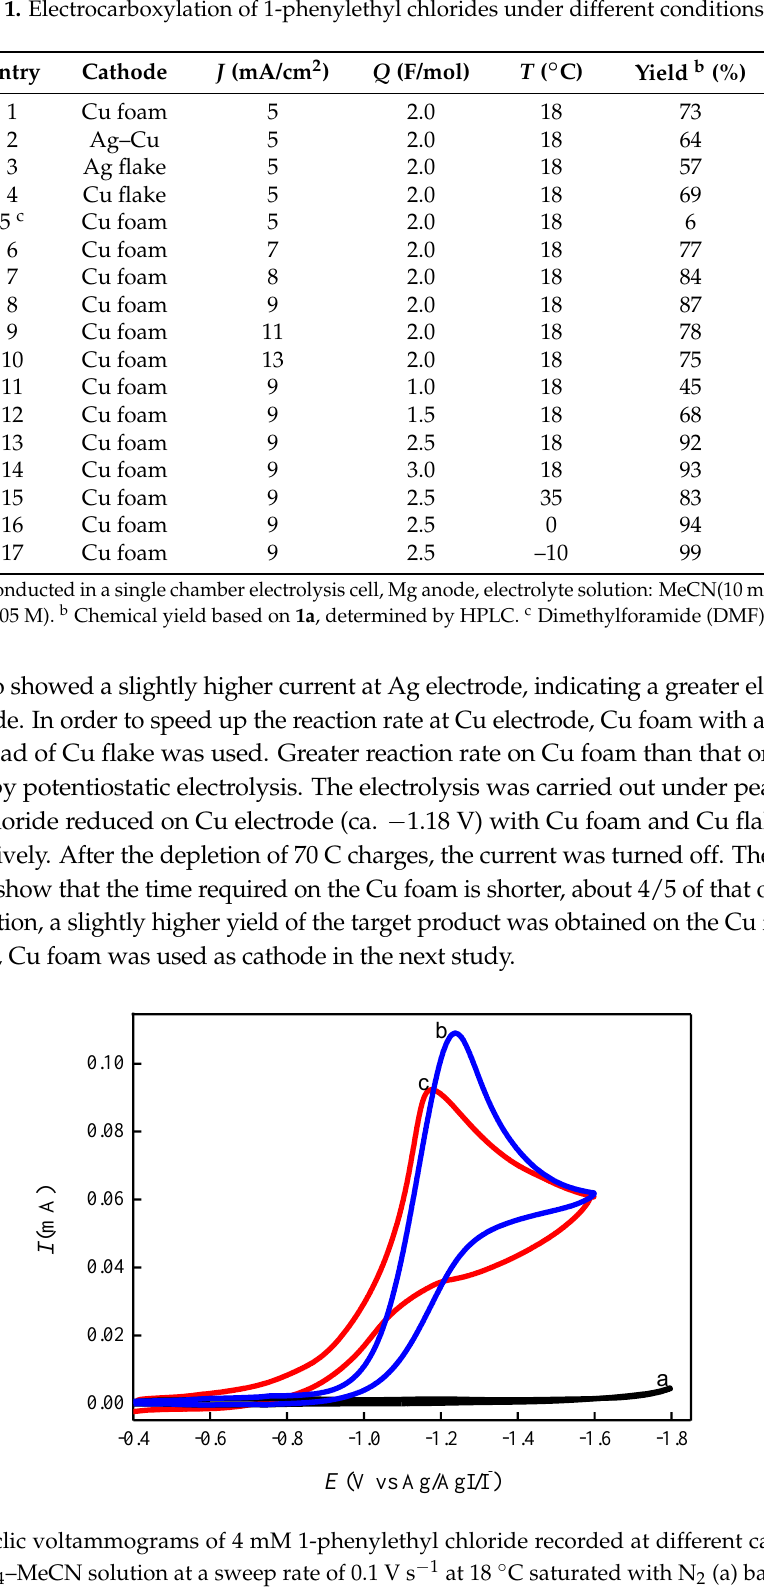
Figure 4 Q – t curve on different cathode (a) Cu foam, (b) Cu flake. Solvents have their own physicochemical and electrochemical properties, and many electrochemical reactions are affected by the nature of the solvents. Thus, the influence of solvent has been studied. The electrolysis was performed in both MeCN and DMF (Table 1, entries 1, 5). We observed that when the reaction was carried out in MeCN using 5 mA cm -2 current density and 2.0 F mol -1 charge, the expected product 2a was obtained in 73% yield. In contrast, only 6% yield of 2a was obtained in DMF under the same conditions. This may be due to the larger solubility of CO 2 in MeCN compared with DMF [32]. The current density ( J ) and charge passed in electrolyses ( Q ) also affected the yield of 2a. In fact, lower yields were obtained at both low and high current densities compared with the result at 9 mA/cm 2 (87%, Table 1, entry 8). The results at low current densities 5 mA/cm 2 and 7 mA/cm 2 (73% and 77%, Table 1, entries 1, 6) can probably be ascribed to side reactions such as the reduction of CO 2 to C1 or C2 compounds [33,34], while the results at high current densities 11 mA/cm 2 and 13 mA/cm 2 (78% and 75%, Table 1, entries 9, 10) can be ascribed to lower current efficiency with increased ohmic component. The highest yield of 2a was achieved with 9 mA/cm 2 current density and 2.5 F mol −1 charge of 1a (92%, Table 1, entry 13). With further increase of consumed charge, the yield of 2a was